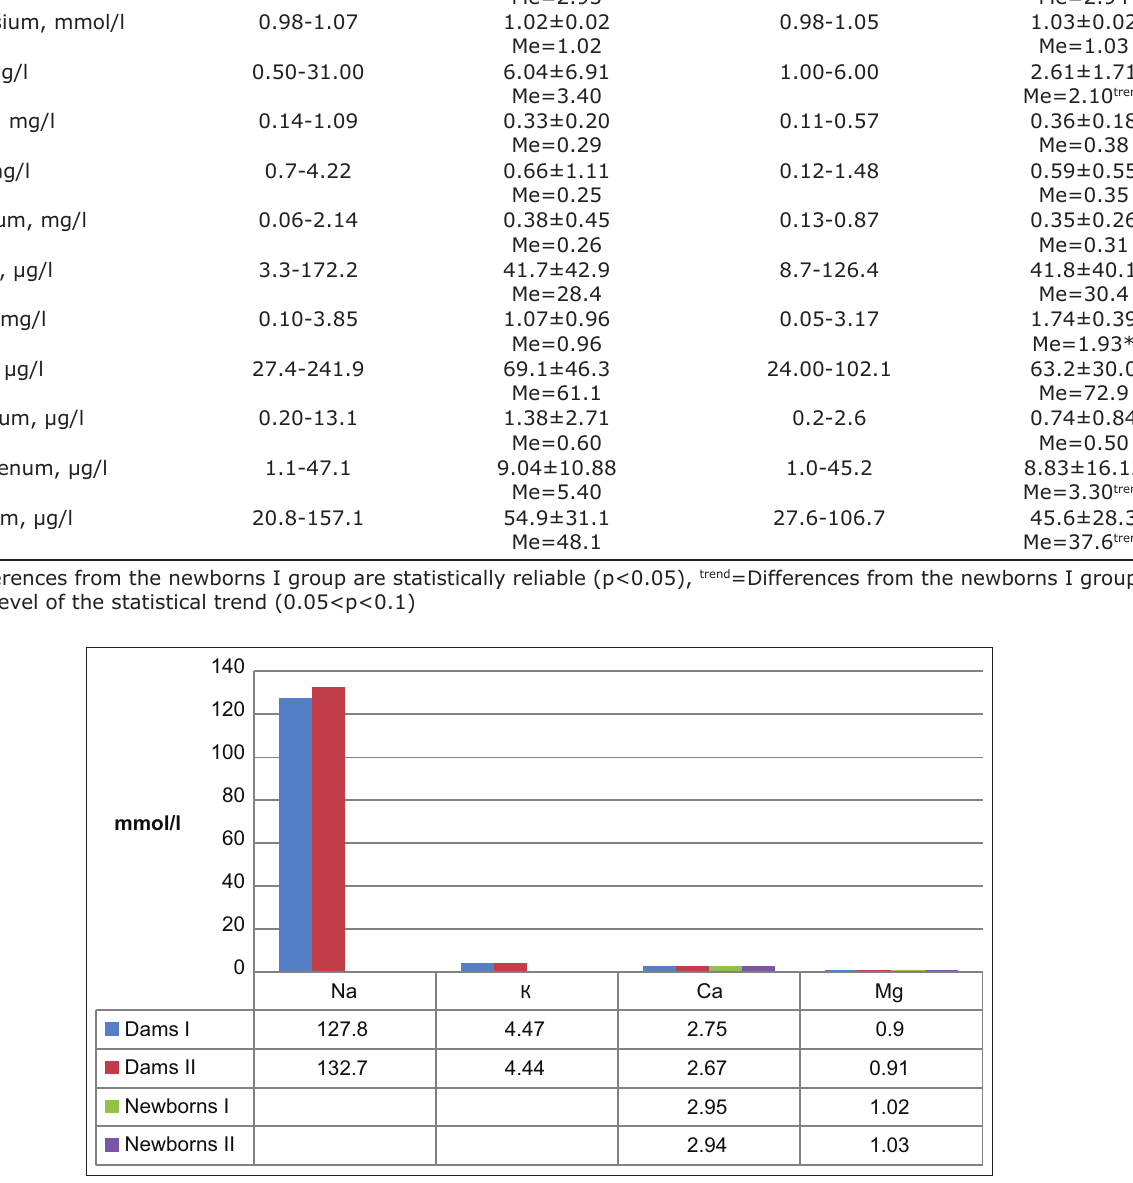
Figure-1: Macroelements content in the blood serum of down-calving cows and newborn calves (median indicator